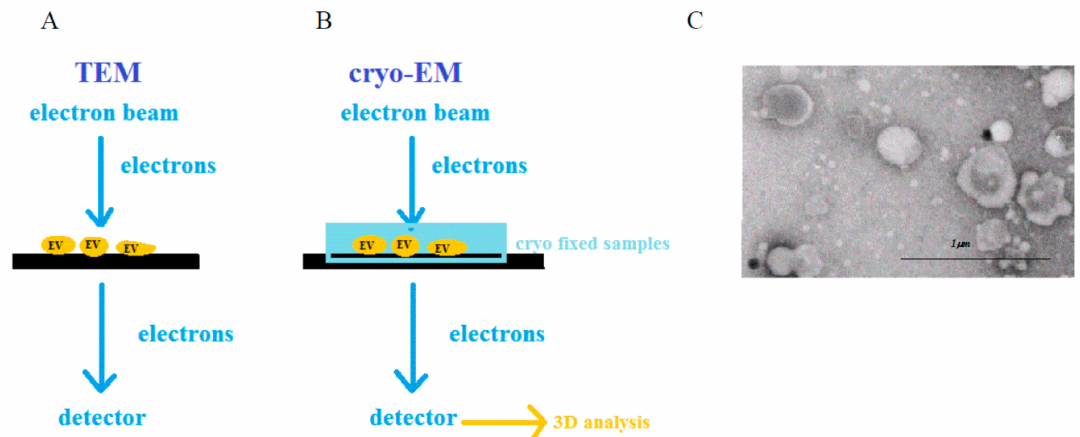
Figure 5. A graphic illustration of transmission electron microscopy (TEM) ( A ) and cryo-TEM ( B ) principles; TEM image of extracellular vesicles collected from plasma of gastric cancer patients ( C